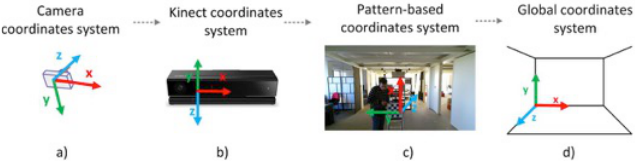
Figure 4. Scheme with the relations to the coordinates transformations between the existing coordinate systems.